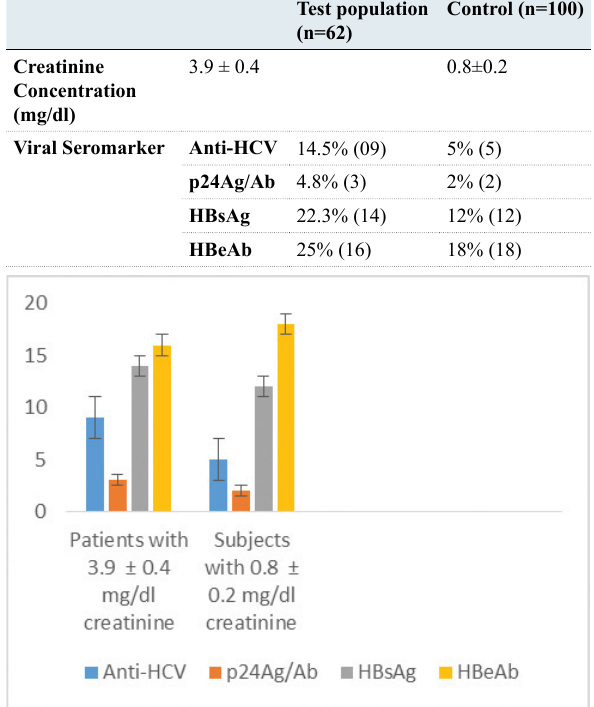
Table 1: Viral seromarkers in the test and control volunteers